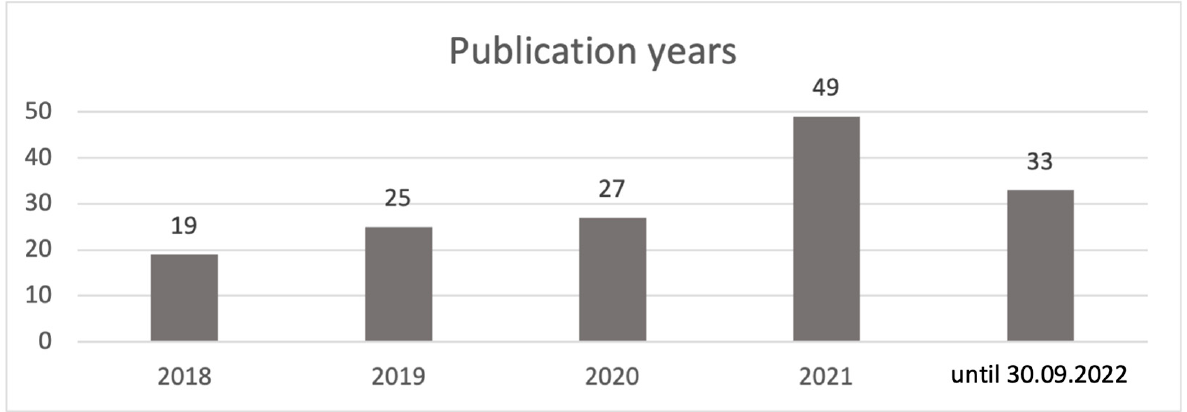
Figure 4. The number of publications from 2018 to 30.09.2022.